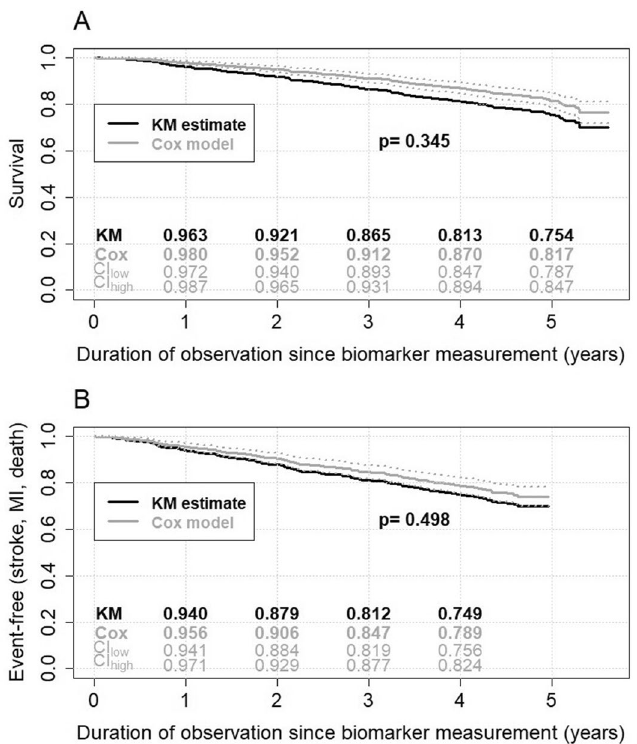
Figure 2. Fit of the multivariable Cox models with 95% confidence interval compared to the estimates from Kaplan–Meier analysis for (A) death and (B) the composite endpoint. The p-value from a calibration test for the Cox model is shown. KM Kaplan–Meier, CI confidence interval, time duration of observation since biomarker measurement. The figure was produced with IBM SPSS Statistics version 25.0 (https:// www. ibm. com/ de- de/ analy tics/ spss- stati stics- softw are) and R version 4.0.0 (https:// www.R- proje ct.